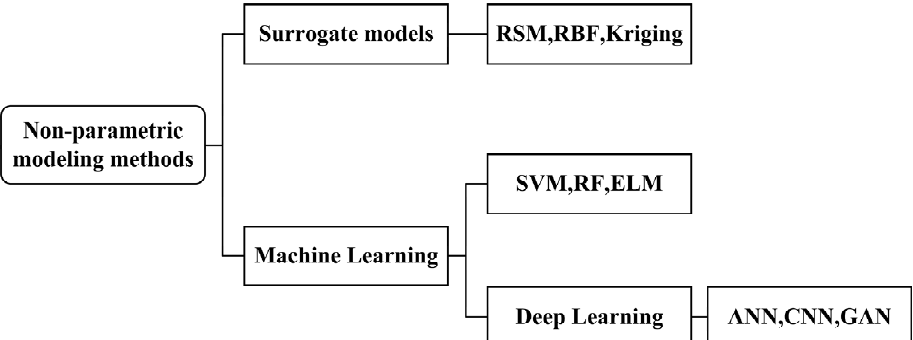
Figure 4. Non-parametric modeling methods classification